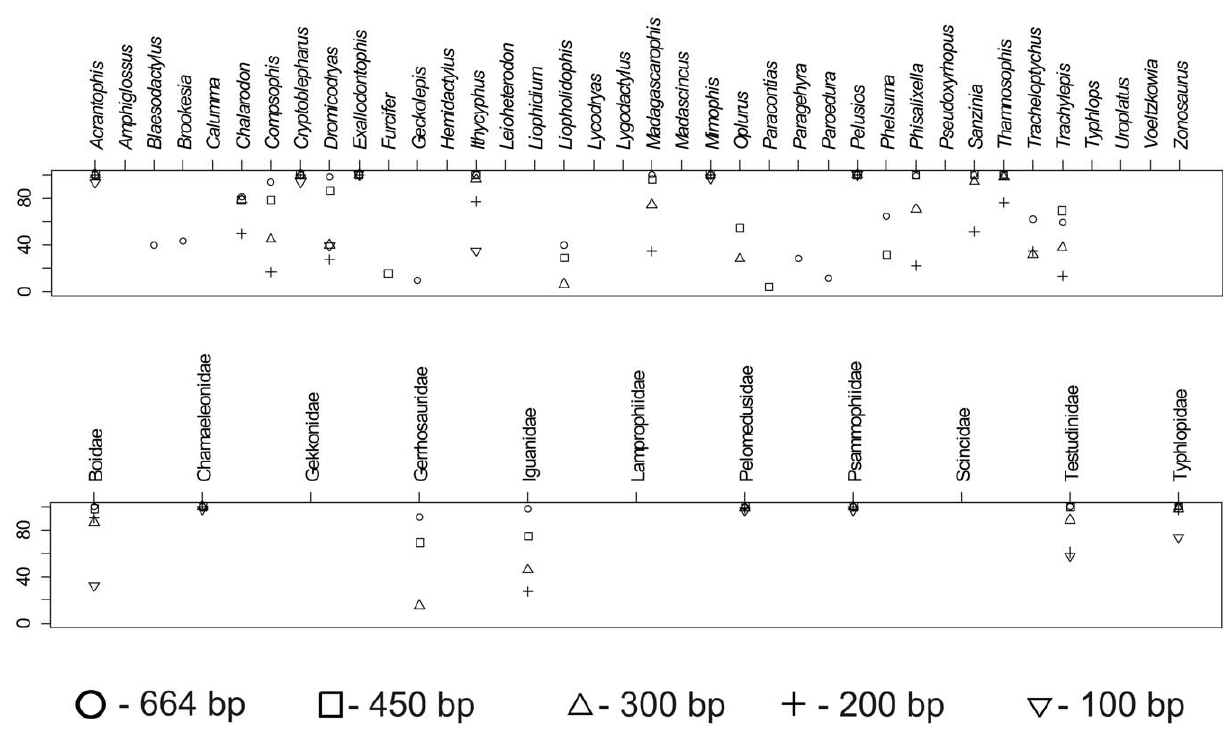
Figure 4. Plot of bootstrap values supporting genera and families with different DNA sequence length. Values for genera (top) and families (bottom) were obtained by neighbor-joining analyses based on DNA sequence fragments of 664 bp (original data set), 450, 300, 200 and 100 bp, respectively.